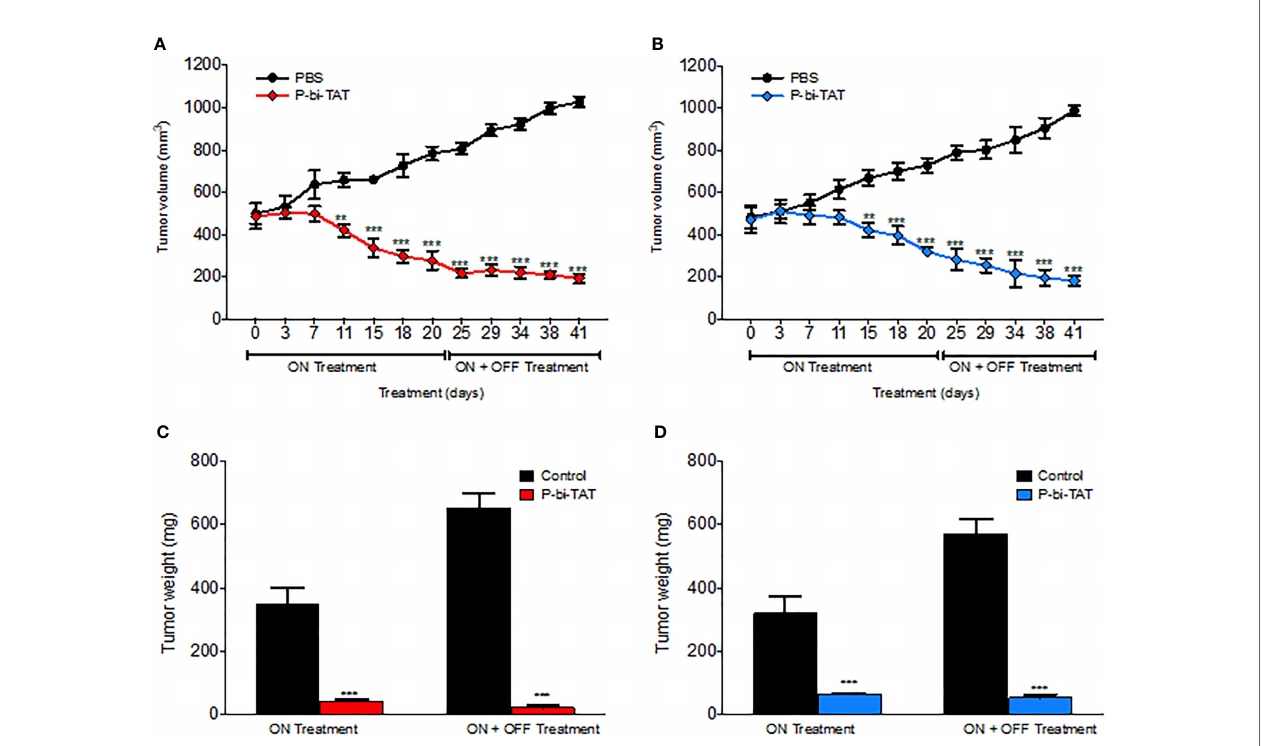
FIGURE 1 | Glioblastoma xenografts implanted in nude mice using U87-luc and primary glioblastoma cells (GBM 052814). Tumor samples were obtained after 21 days of treatment with subcutaneous injection of either PBS and P-bi-TAT (10 mg/kg body weight) (ON treatment) OR an additional 21 days after discontinuation of treatment (ON + OFF treatment model). (A, C) Tumor volumes and Tumor weight (U87-luc) (B, D) Tumor volumes and Tumor weight (GBM 052814).Values are expressed as mean ± SD, ***P < 0.0001, **P <